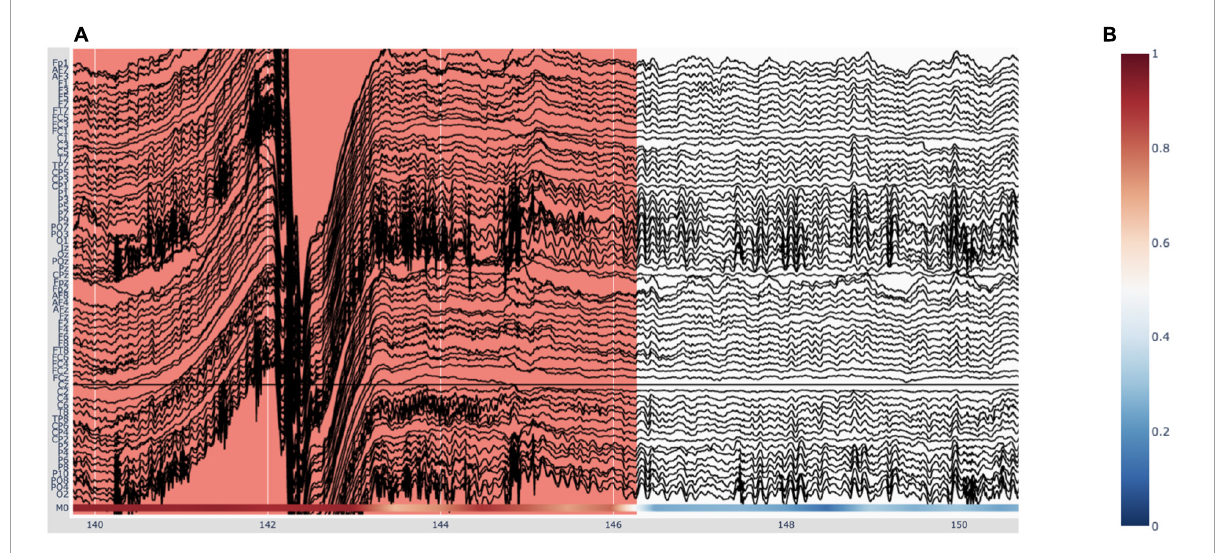
FIGURE6 Visualizing deep-learning predictions of artifacts in Robin’s Viewer (RV). (A) Example timeframe of an electroencephalography (EEG) file displayed in RV. An annotated artifact is illustrated here (in red) with the respective deep-learning model predictions at the bottom of the plot, in accordance with the colorbar seen in panel (B) . (B) The color indicates predicted probability of an artifact. Red (1) corresponds to high probability and blue (0) to low